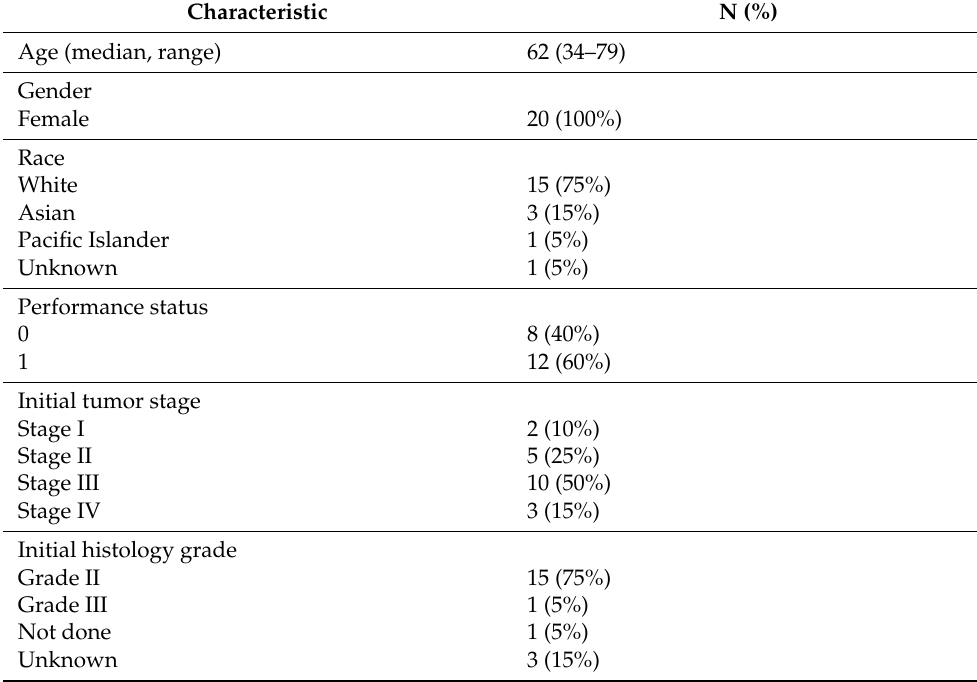
Table 1. Patient characteristics and treatment variables (N =